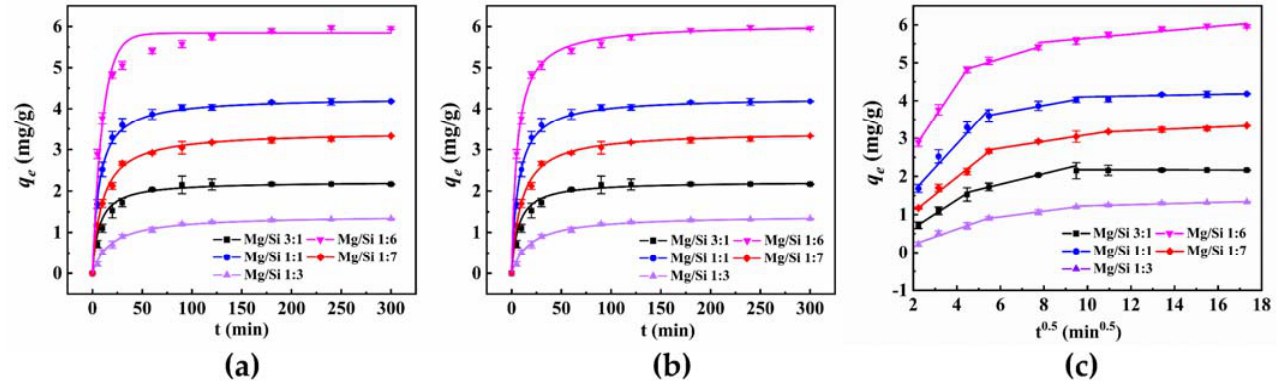
Figure 4. Removal of 4 − NP by Mg/Si 1:6 fitted with nonlinear pseudo − first − order kinetic model ( a ), nonlinear pseudo − second − order kinetic model ( b ), and intraparticle diffusion model ( c ).